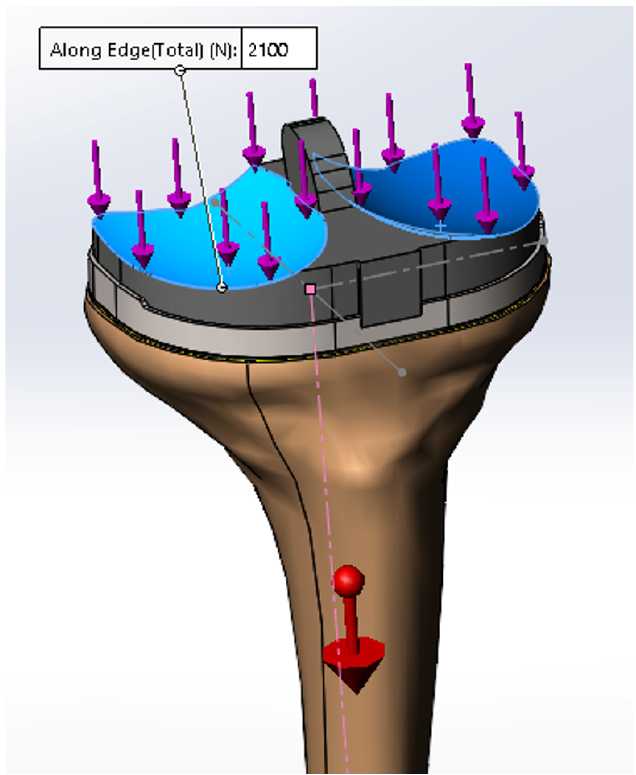
Figure 7. Force evenly distributed over the two contact surfaces.